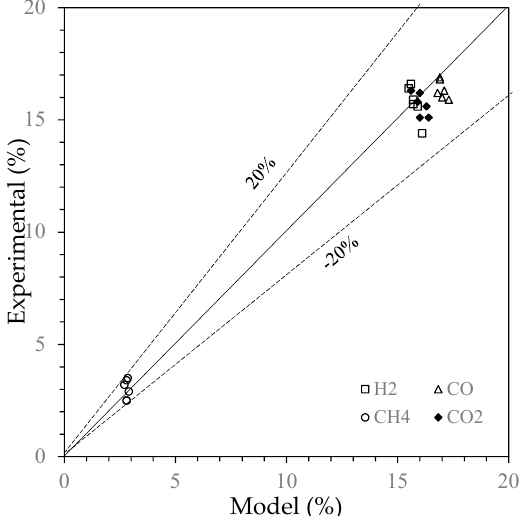
Figure 3. Comparison between modeled and measured produced gas composition for BSG gasification .